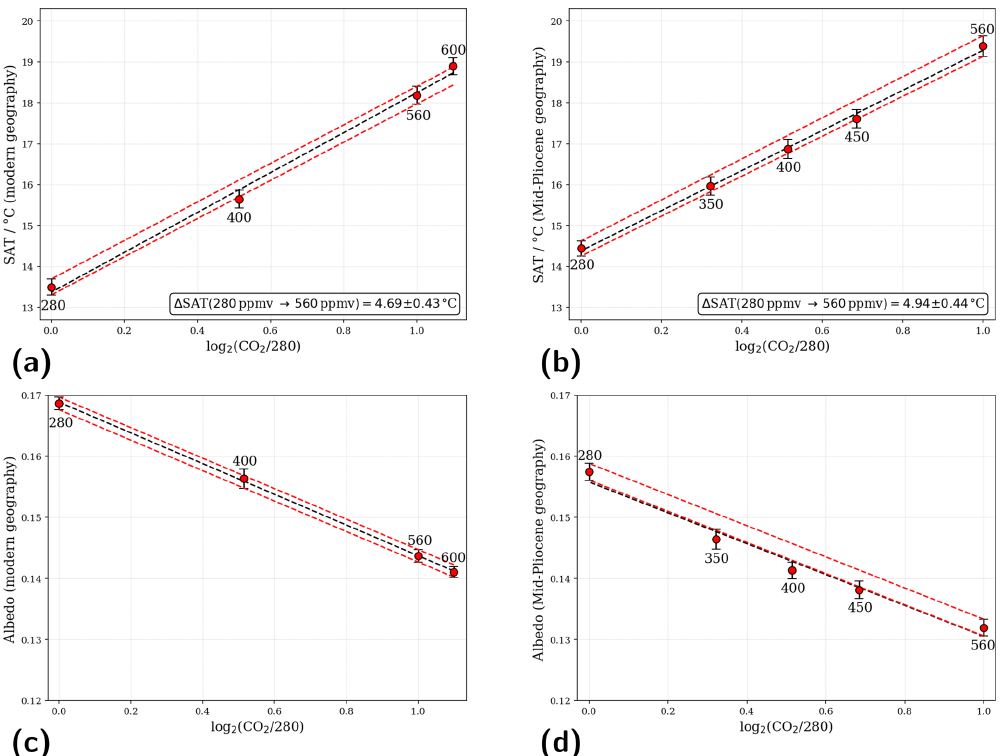
Figure 13. Sensitivity of modelled global mean surface air temperature (SAT) (a, b) and surface albedo (c, d) to variations in the volume mixing ratio of carbon dioxide (CO 2 ) in units of parts per million by volume (ppmv). Shown are model configurations of (a, c) modern geography and (b, d) mid-Pliocene paleogeography. Data points are annotated with corresponding CO 2 concentrations. Variability of SAT and surface albedo over the analysis period is illustrated by vertical error bars. Black dashed regression lines represent a best linear fit for all simulations considered, and red dashed regression lines highlight a corridor of perfect linearity considering simulations with 280 and 560ppmv as a guidance. For mid-Pliocene surface albedo, the strong nonlinearity with regard to CO 2 leads to the best linear fit being outside this